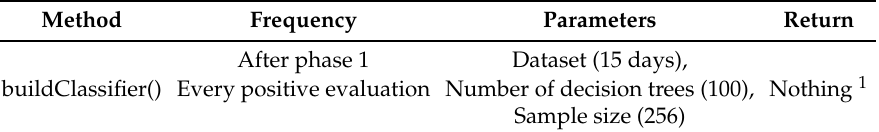
Table 3. Configuration parameters to train the Isolation Forest